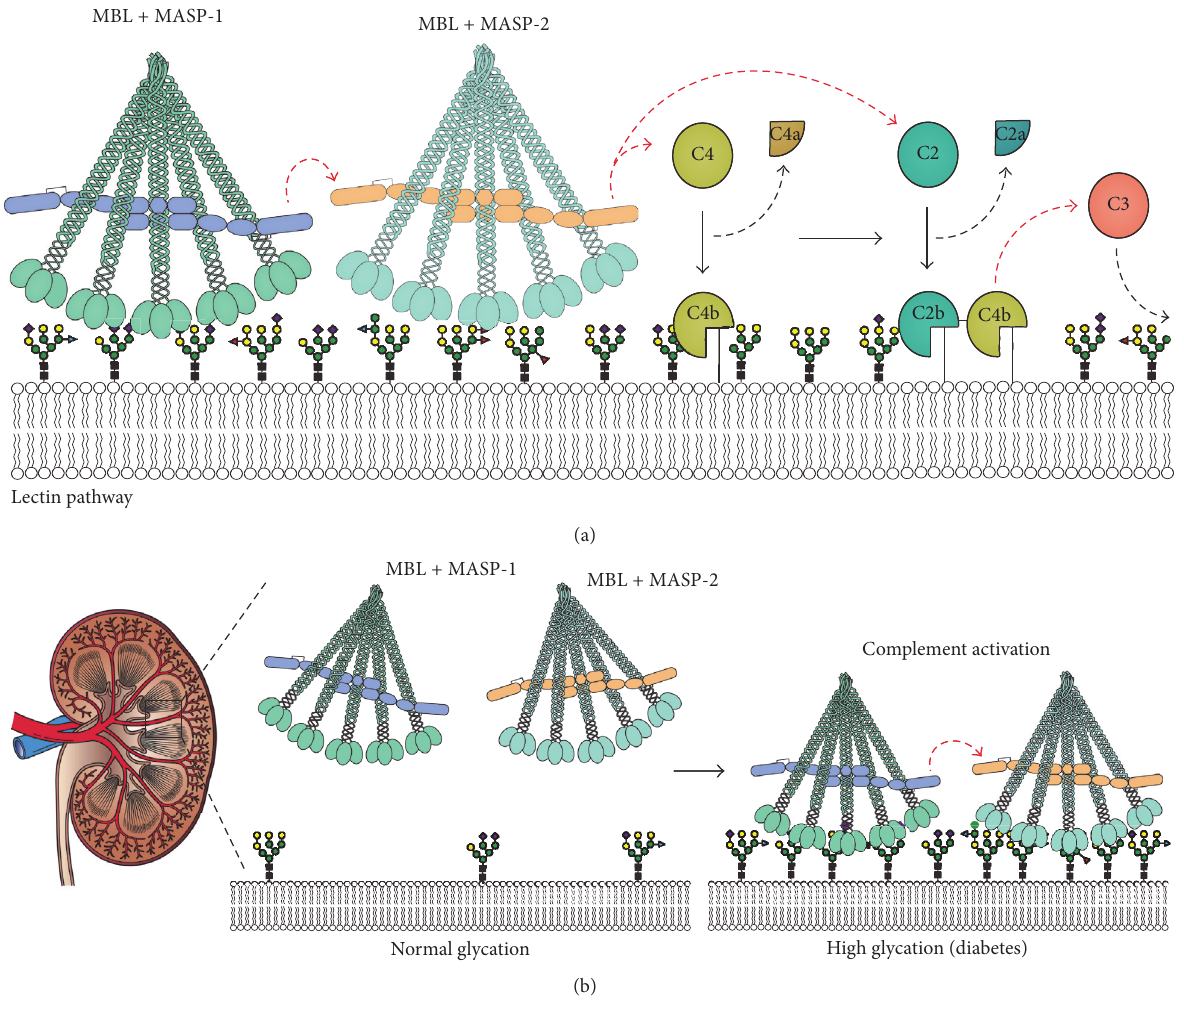
Figure 1: Overview of the lectin pathway of the complement system and study hypothesis. (a) Specific surface-sugar structures are recognized by MBL that leads to activation of the lectin pathway. The activation proceeds as an enzyme cascade with proteins acting as cofactors for each other thus generating opsonins for enhanced cellular recognition (C3b), anaphylatoxins that drive local inflammation (C3a and C5a), and terminally the membrane-attack complex (C5b-9) that mediates cell lysis. (b) Under normal glycemia MBL is unable to bind host cell-surfaces (left panel). However, during hyperglycemia the cellular surface may be altered, which mediates recognition by MBL and activation of the complement